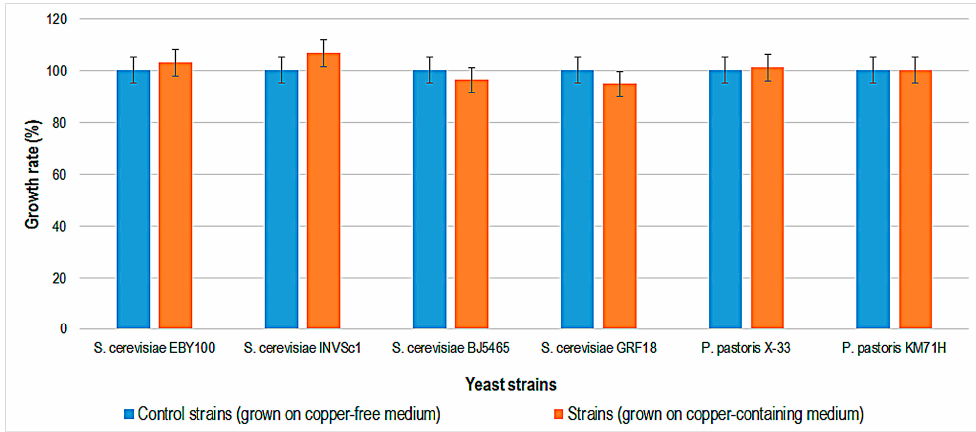
Figure 4. Growth rate (%) for di ff erent yeast strains, after 48 h of incubation, at 30 °C, in Yeast- Peptone-Dextrose medium without or with copper (1 mM).